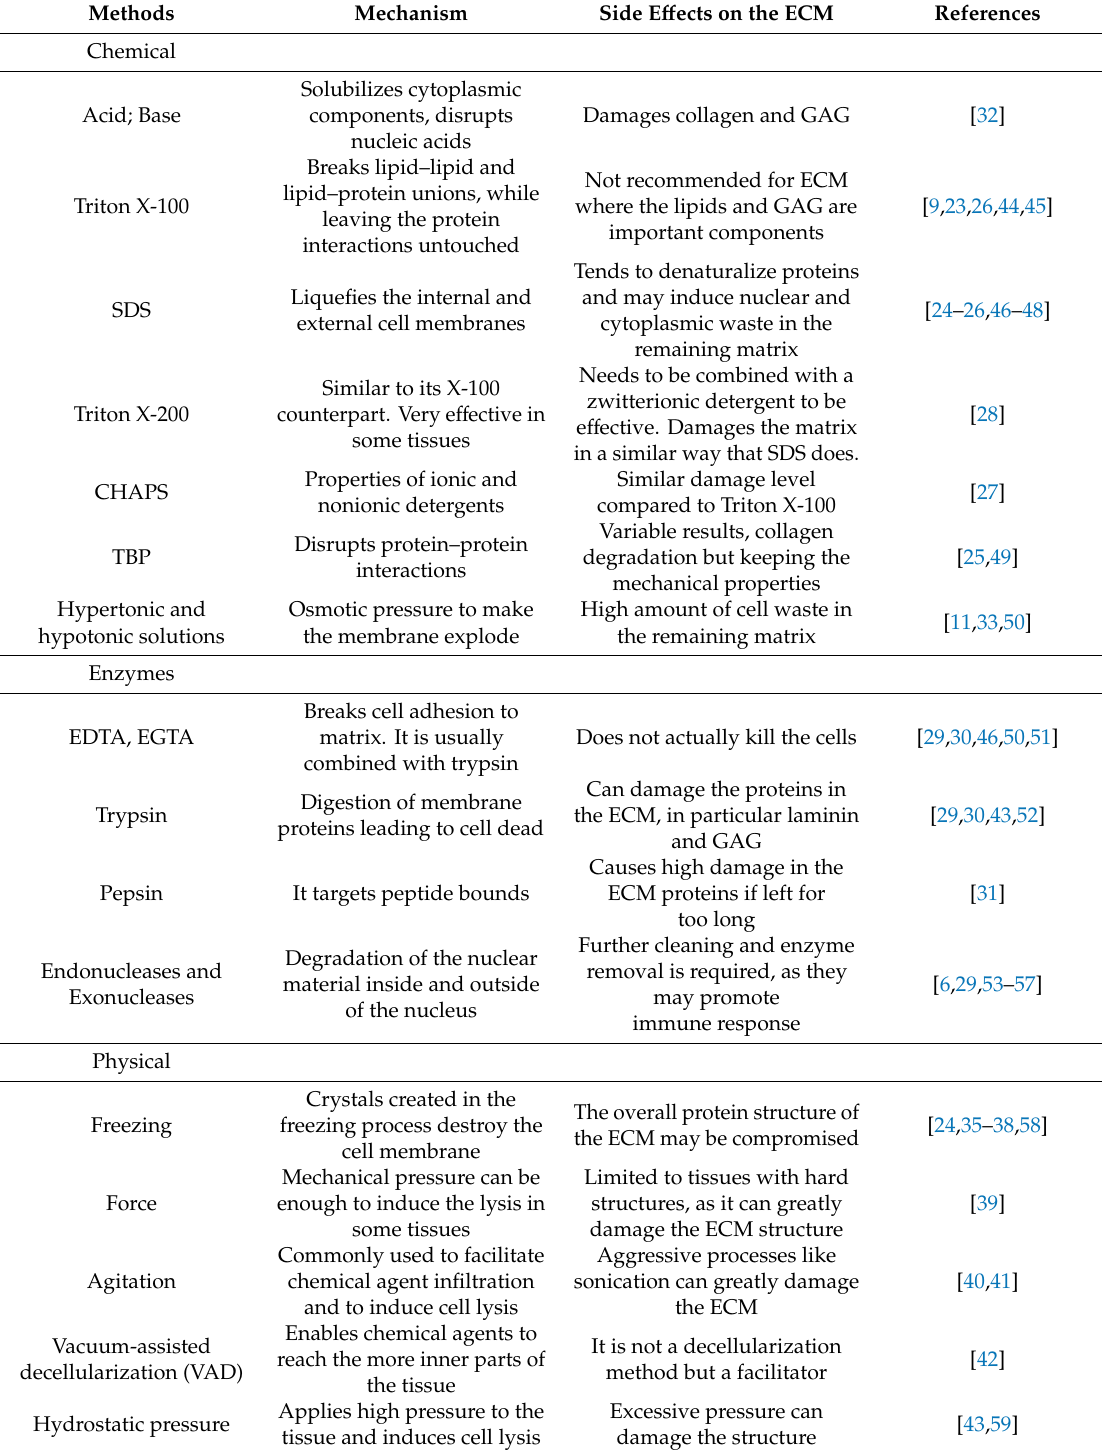
Table 1. Methods used in decellularization